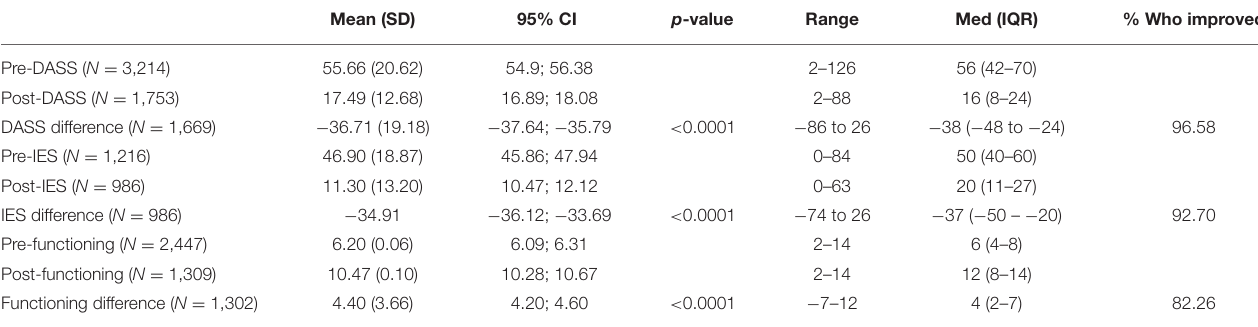
TABLE 3 | Distress and functioning pre- and